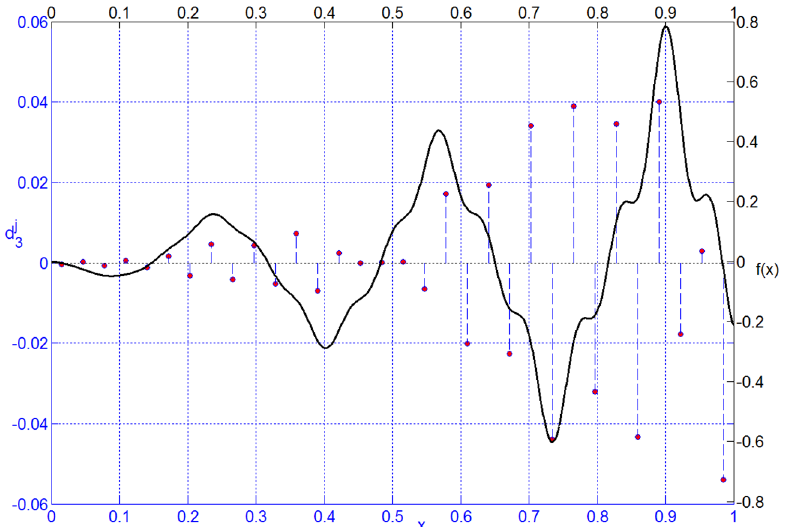
Fig 2. Distribution of wavelet